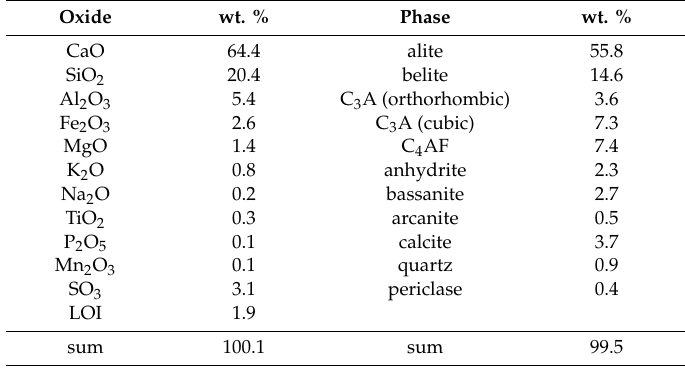
Table 1. Chemical (XRF) and mineralogical composition (XRD) of the CEM I 42.5